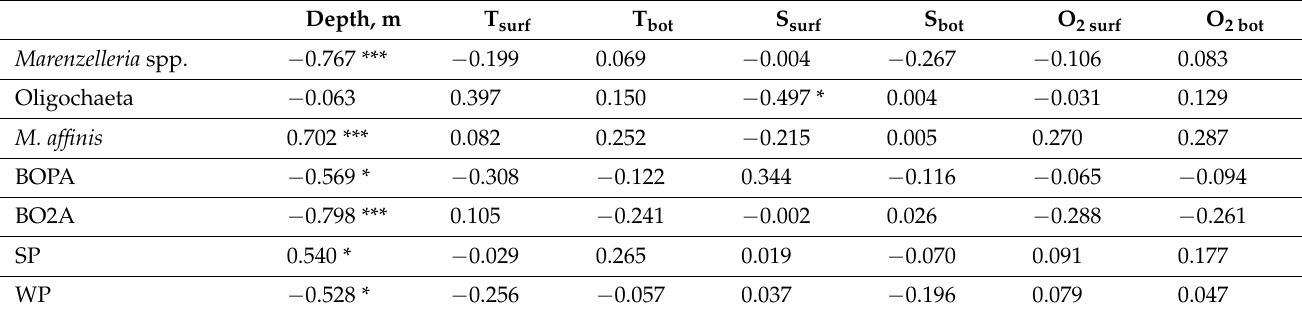
Table 3. Spearman Rank Order Correlations, benthic species abundance, BOPA and BO2A index, indices of sediment (SP), and water pollution (WP) indices with environmental variables. * p ≤ 0.05, *** p ≤